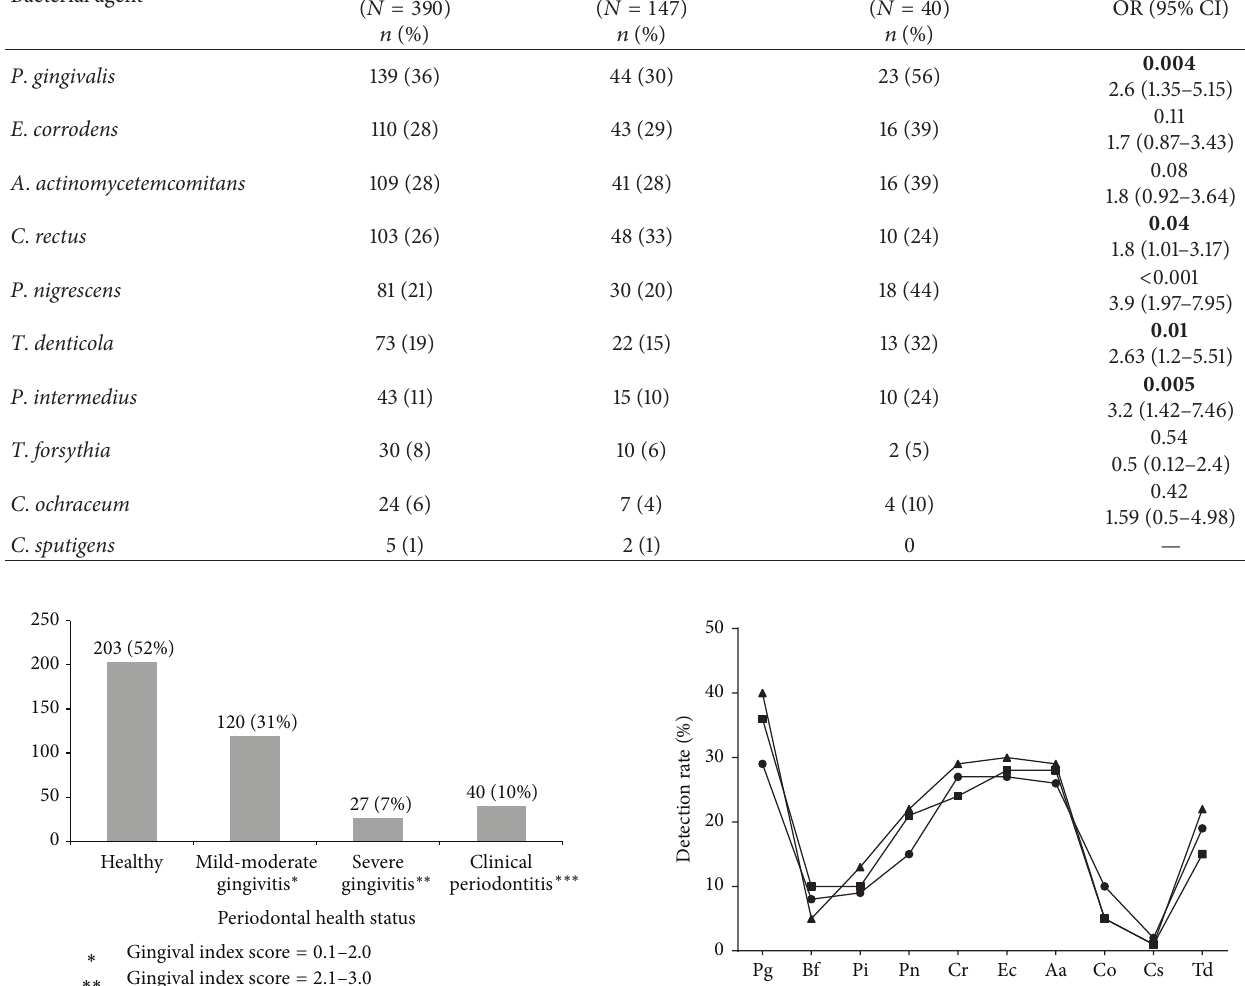
Table 2: Detection rates and association with periodontal disease of ten periodontopathogenic bacteria. Bacterial agent